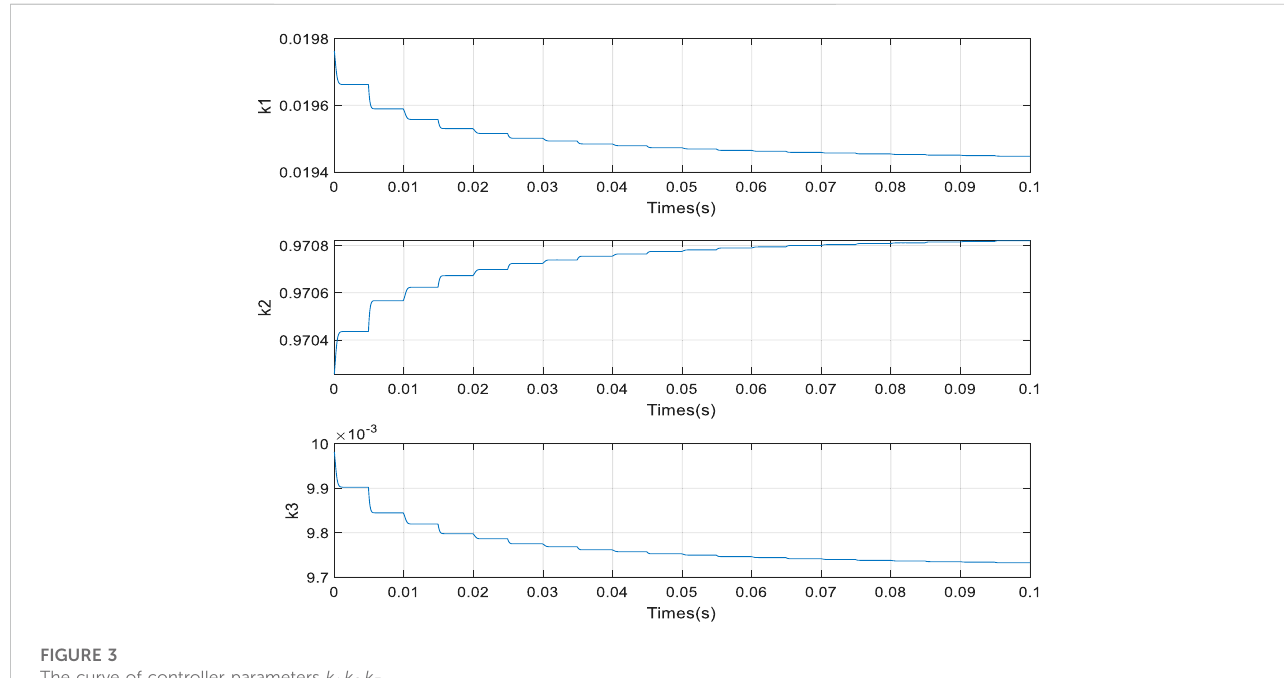
FIGURE 3 The curve of controller parameters k 1 , k 2 , k 3